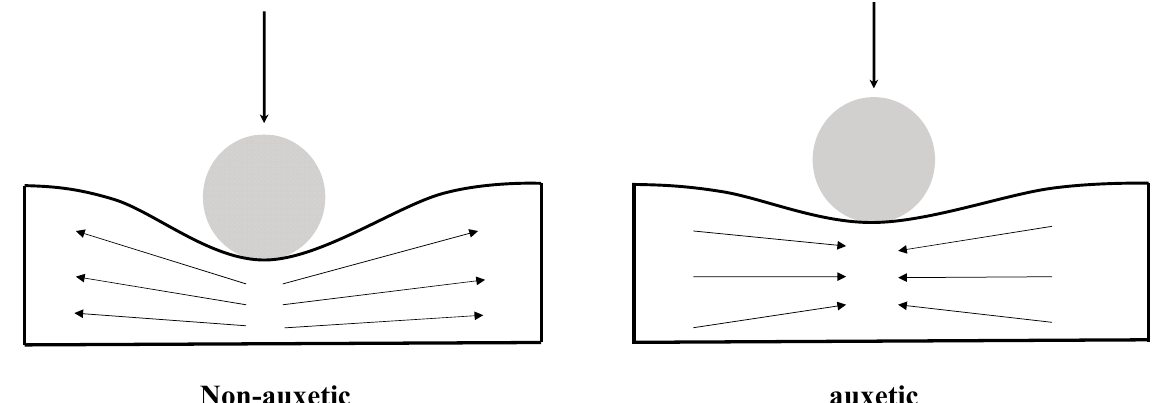
Figure 1. A comparison of indentation behavior between a non-auxetic material ( left ) and an auxetic material ( right ) [41].